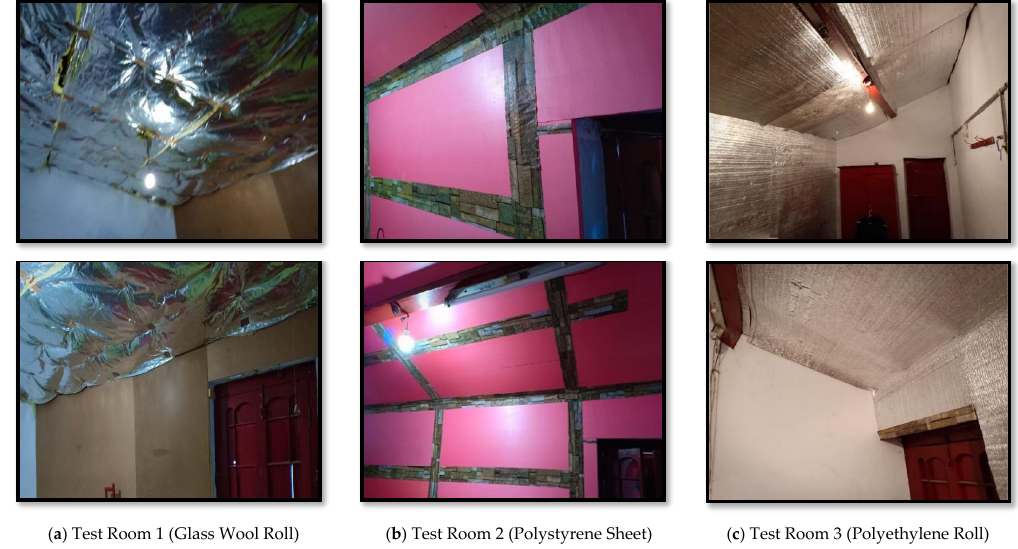
Figure 5. Interior pictures of test rooms with insulations being applied.